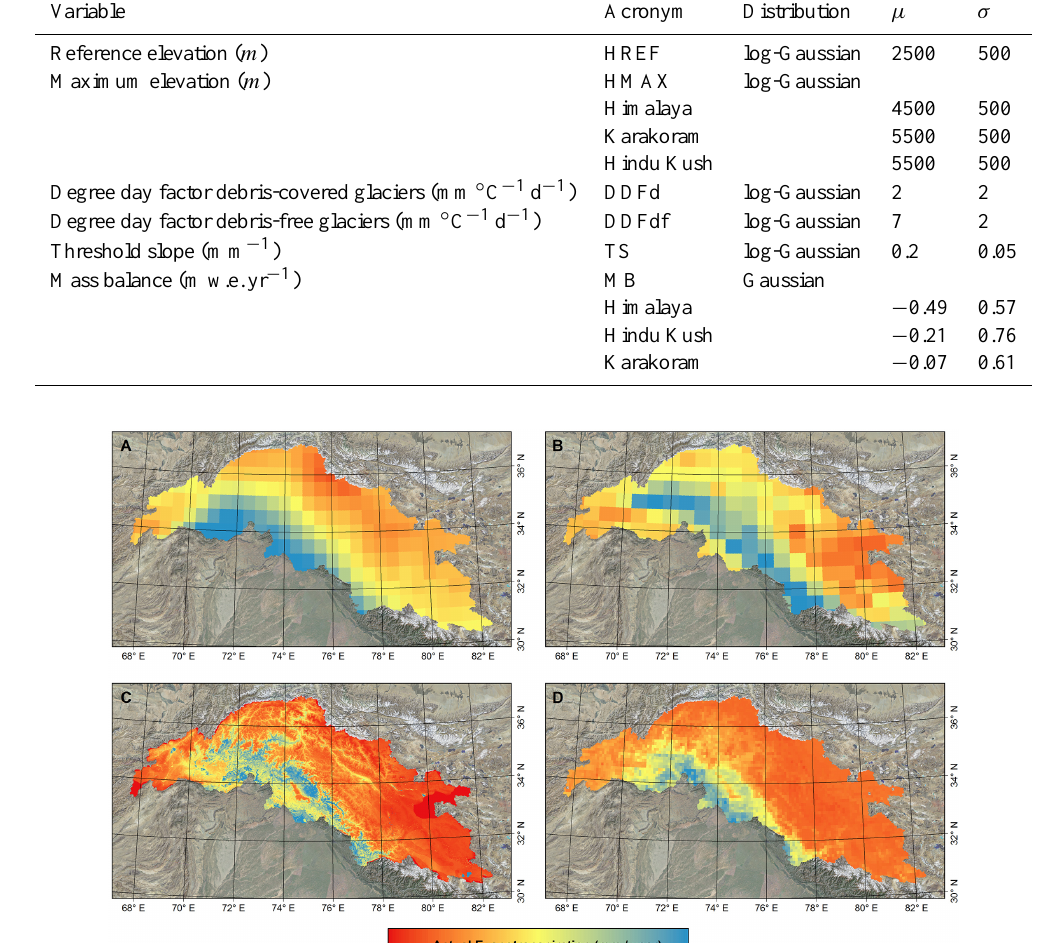
Table 1. Averages ( µ ) and standard deviations ( σ ) of predictors for the precipitation gradient. Values and ranges are based on literature as follows: HREF and HMAX: Hewitt (2007, 2011), Immerzeel et al. (2012b, 2014b), Putkonen (2004), Seko (1987) and Winiger et al. (2005); DDFd and DDFdf: Azam et al (2012), Hagg et al. (2008), Immerzeel et al. (2013), Mihalcea et al. (2006) and Nicholson and Benn (2006); MB: Kääb et al. (2012a).